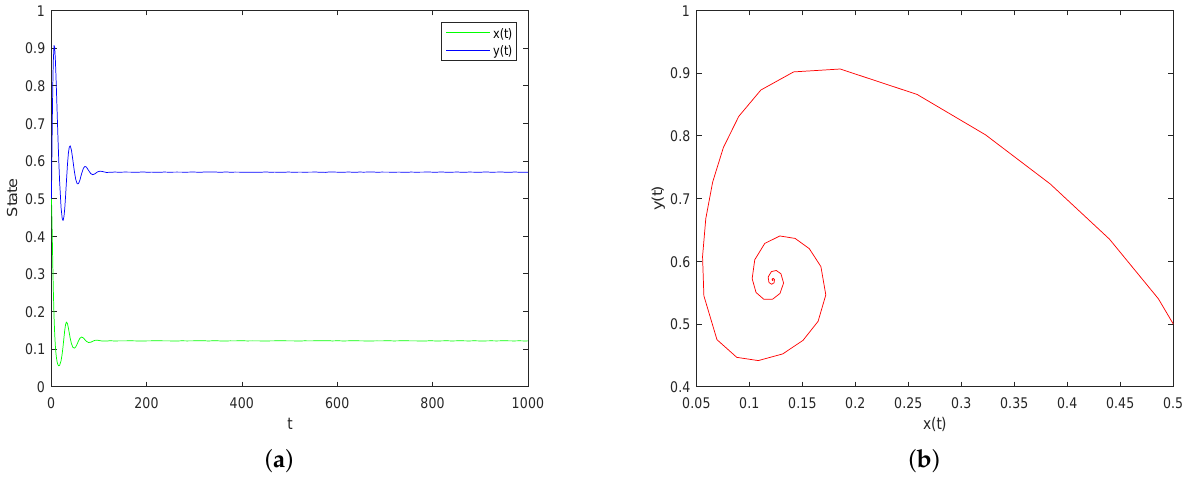
Figure 1. ( a ) Time series and ( b ) phase portrait of E ∗ for system (1) when τ 1 = 0 and τ 2 = 0. Other parameters are the same as in (32).